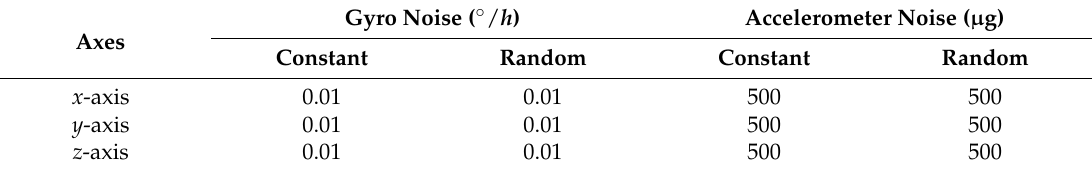
Table 3. Sensor errors.